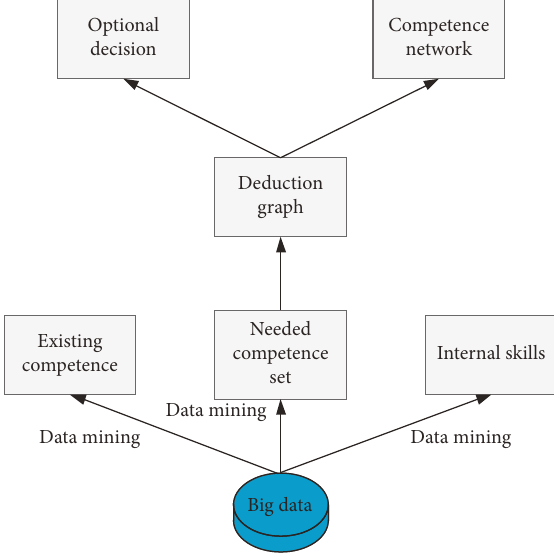
Figure 1: Big data research roadmap.